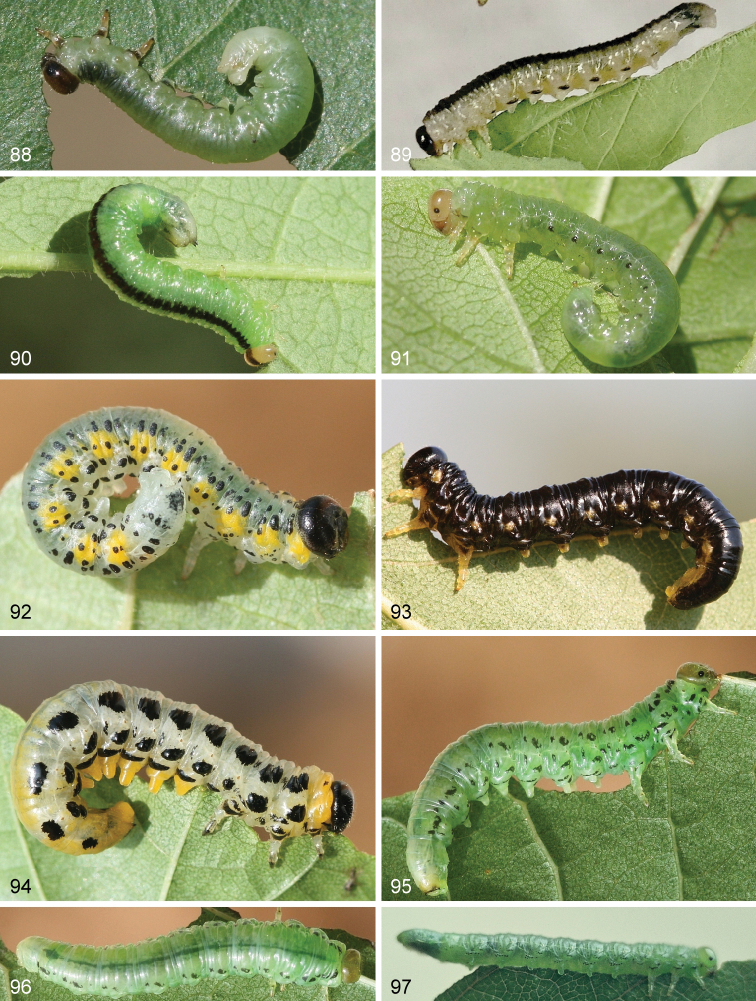
Larvae of Nematinae88Hemichroa
australis89Nematus
lonicerae (photo E. Altenhofer) 90Nematus
wahlbergi91Nematus
lucidus92Euura
melanocephalus93Nematus
latipes94Nematus
septentrionalis95–96Nematus
alniastri97Nematus
princeps (photo V. Vikberg).